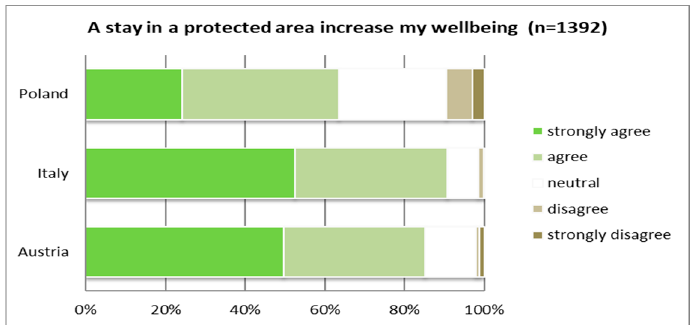
Figure 6. Benefits associated with a stay in a PA regarding personal well-being ( p ≤ 0.01).